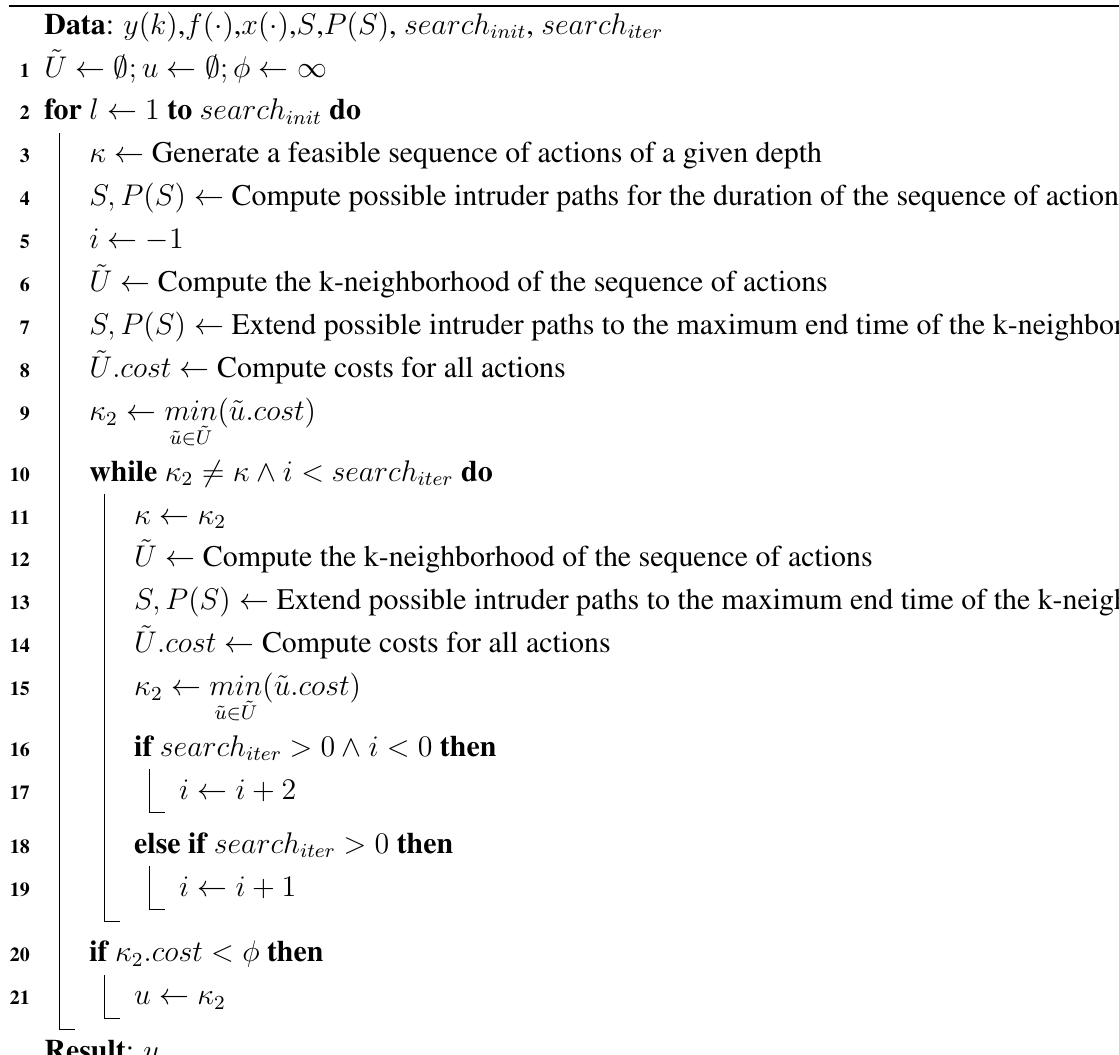
Algorithm A1: The localSearch() heuristic to find a local minimal cost action for the UAVs. Data : y ( k ) , f ( · ) , x ( · ) , S , P ( S ) , search